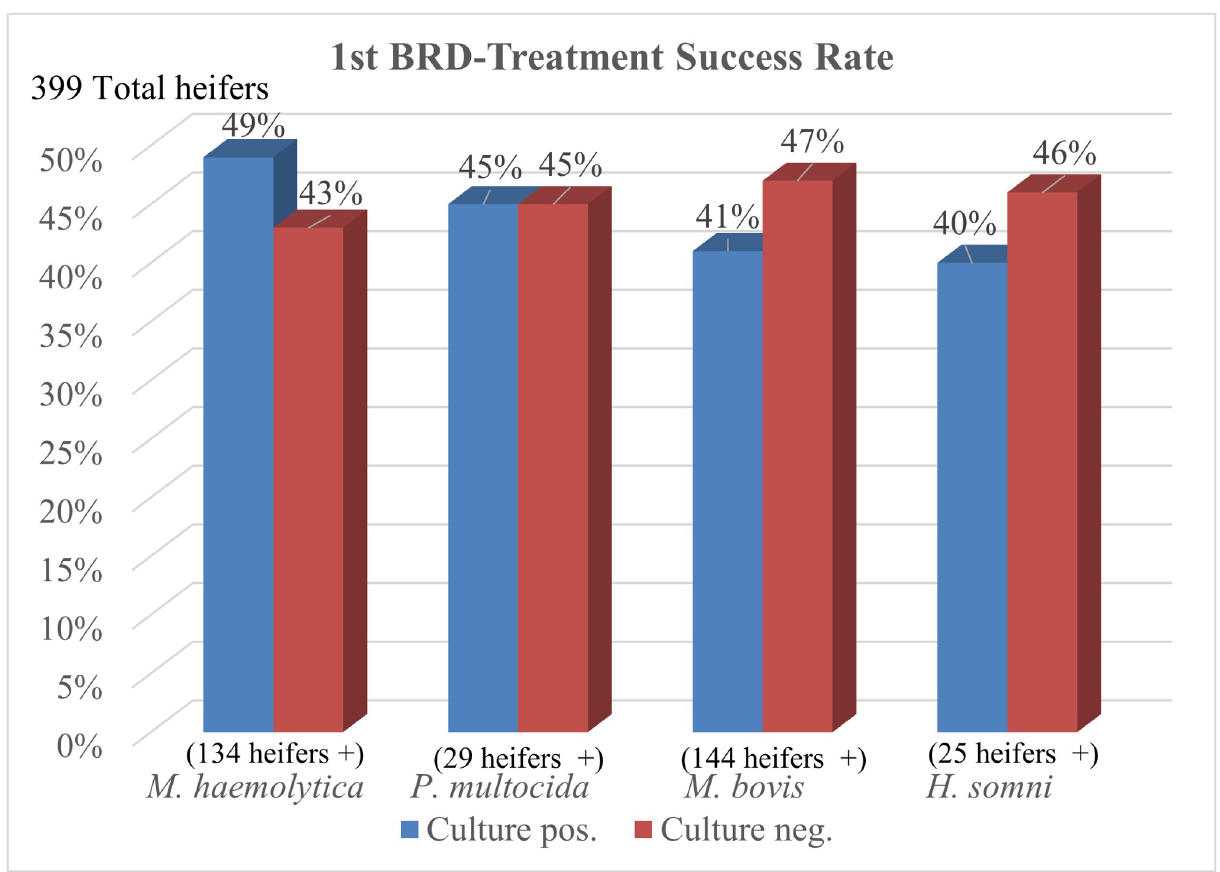
Fig 4. 1 st BRD-treatment success rate by culture of bacterial pathogen via nasopharyngeal swab.